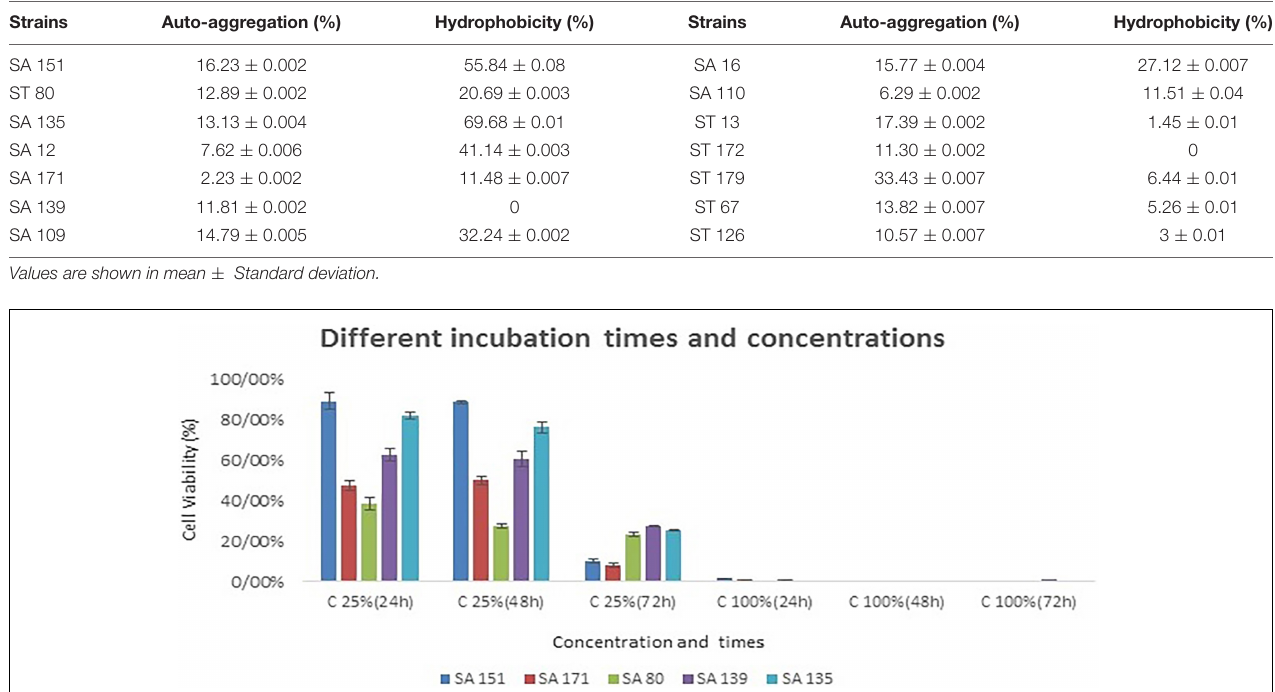
rate of hydrophobicity and auto-aggregation were observed in SA 151, SA 135, and in ST 179, ST 13,